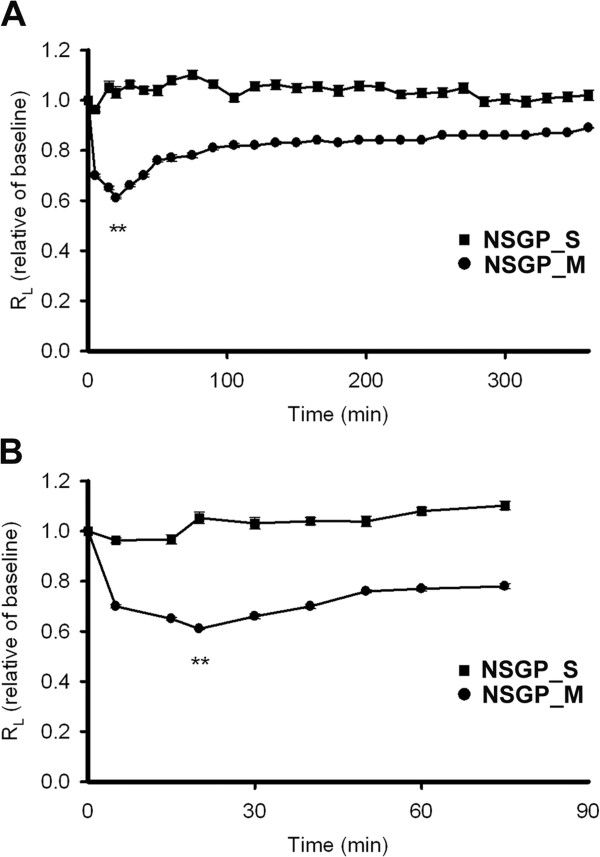
The CTCM had a bronchodilator effect. Guinea pigs were treated with a nebulized form of the CTCM, and the pulmonary resistance (RL) was significantly reduced (to 61.0 ± 0.01% of the baseline) 20 min post-CTCM treatment, while no change was seen in the animals treated with saline. (A) Overview of the 7-hr period. Comparison between the NSGP_S and NSGP_M groups. (B) Comparison of the different groups of sensitized animals in the first hour (repeated measures ANOVA with a Mauchly post-hoc test; **P <0.01). NSGP_S: unsensitized guinea pigs treated with saline by nebulization; NSGP_M: unsensitized guinea pigs treated with 0.06 g/ml CTCM for 5 min by nebulization.